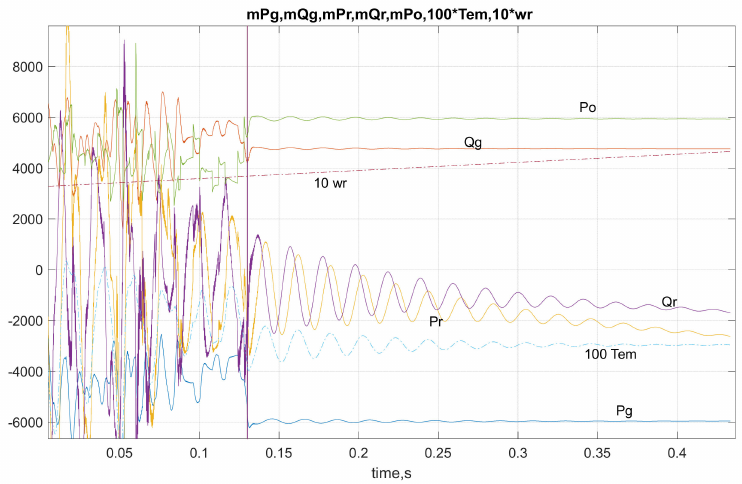
Figure 31. Active power of stator Pg , rotor Pr and load Po and reactive power of stator Qg , rotor Qr and electromagnetic torque of DFIG generator (* 100) for protection a, at variable rotor speed wr (*